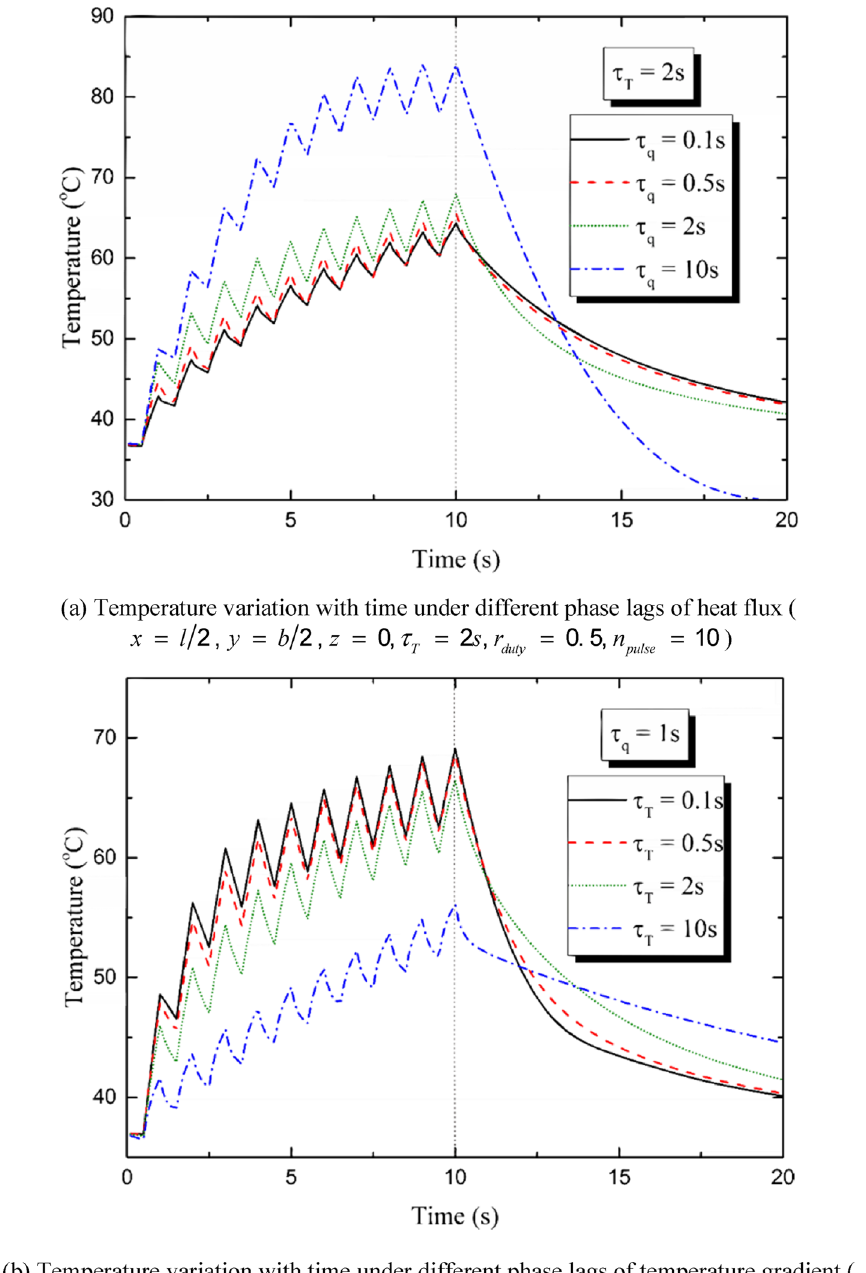
Figure 6. Influences of the phase lags on the temperature variation induced by repetitive laser